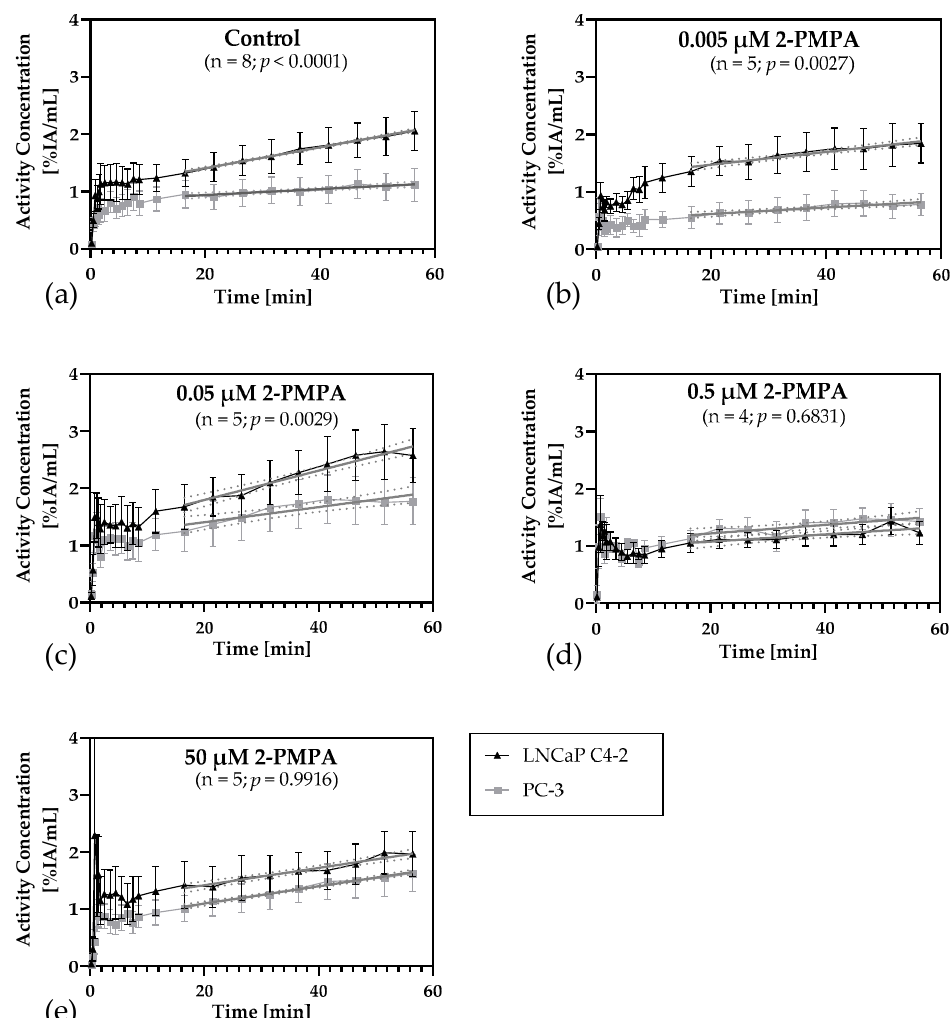
Figure 2. Time-activity curves of [ 18 F]siPSMA-14 accumulation of control measurements and various inhibitor concentrations based on the mean and SEM of the respective experiments. Additionally, the linear regression lines and their respective 95% confidence intervals (dotted lines) starting 16 min after scan initiation have been added. A p -value <0.05 indicates significant differences in the slopes of the graphs based on linear regression analysis. For all inhibitor concentrations ( b – e ) and including the control ( a ), only a minimal increase in radiotracer activity concentration [%IA/mL] is observed for the PSMA − negative tumors, as indicated by the regression lines. While at the lowest inhibitor concentration ( b ) and in the control ( a ) there was a significantly higher activity concentration detectable in the PSMA+ tumors, and differences in the [ 18 F]siPSMA-14 uptake between the two tumor types decreased with increasing inhibitor concentration. At an inhibitor concentration of at least 0.5 µM 2-PMPA there are no signi fi cant di ff erences between PSMA+ and PSMA − tumors, as indicated by the overlapping SEMs. This suggests a specific inhibition of [ 18 F]siPSMA-14 in PSMA+ tumors with increasing 2-PMPA concentration.